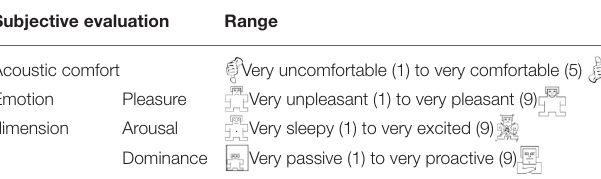
TABLE 3 | Contents of the emotional evaluation